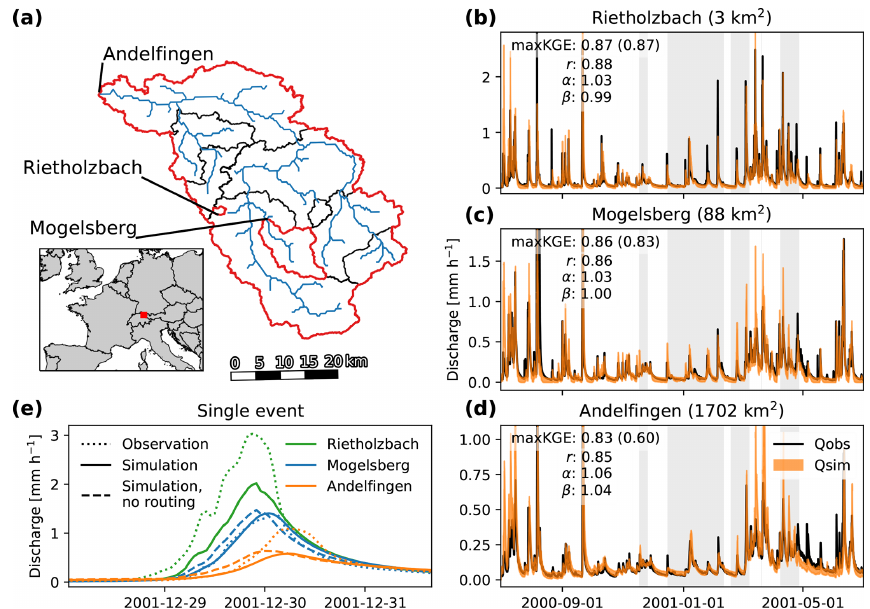
Figure 10. Application of dS2 to the Thur Basin in Switzerland. Panel (a) depicts the stream network, and the catchments used in this example are highlighted in red: Rietholzbach, Mogelsberg and Andelfingen. Panels (b) to (d) present the model output in the three basins, covering different orders of catchment size. The shaded orange region shows the minimum and maximum discharge of the 100 best runs out of 25000, selected based on KGE value. Periods where more than 20% of the entire basin is covered with snow are indicated with the grey background. Performance values show the statistics for the best model run, with the value between brackets showing the model performance when the routing module is disabled. Graph (e) shows how a single precipitation event is translated through the different (sub-)basins, where the dotted line indicates the observed discharge, the solid line represents the simulated discharge and the dashed line represents the simulated discharge without a temporal delay induced by the routing module. Note that the simulation result without routing for Rietholzbach overlaps the simulation result with